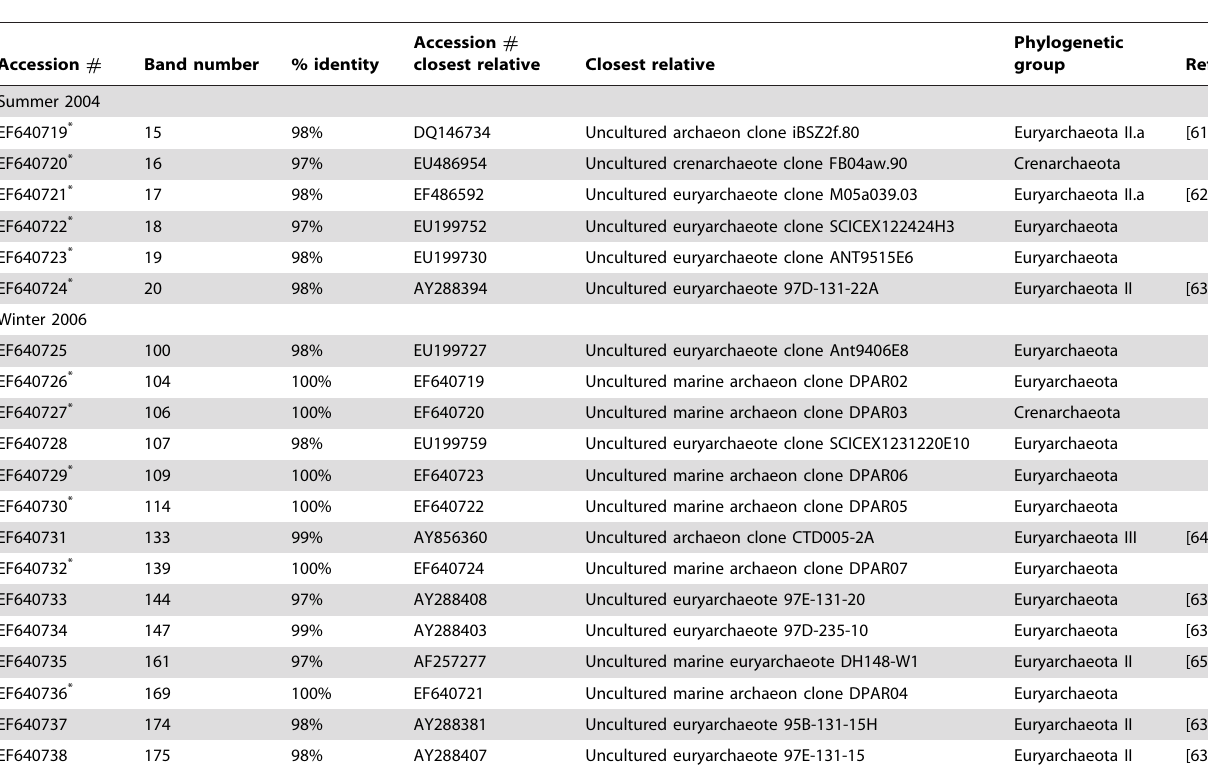
Table 4. List of GenBank accession number and closest relative to 16S rDNA archaeal sequences obtained from DGGE.